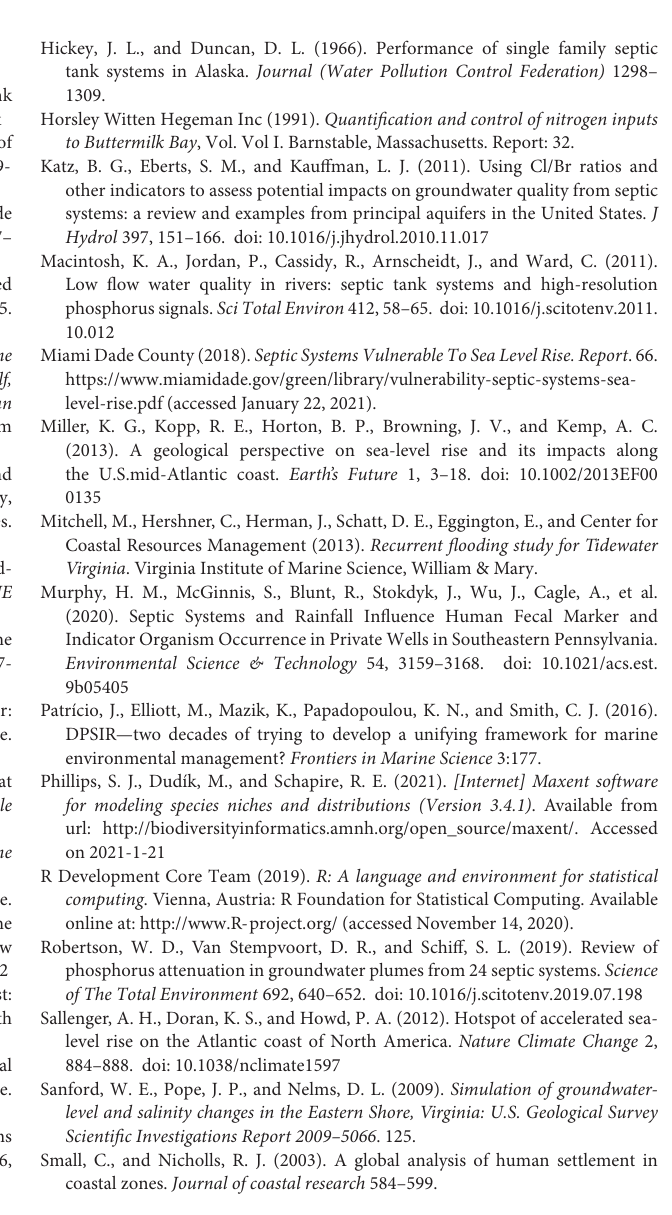
Supplementary Figure 1 | Example of results from the Tidewater Hot Spot analysis, focused on two areas with high concentration of repair permit hot spots. The different categories of hot spots are shown in the